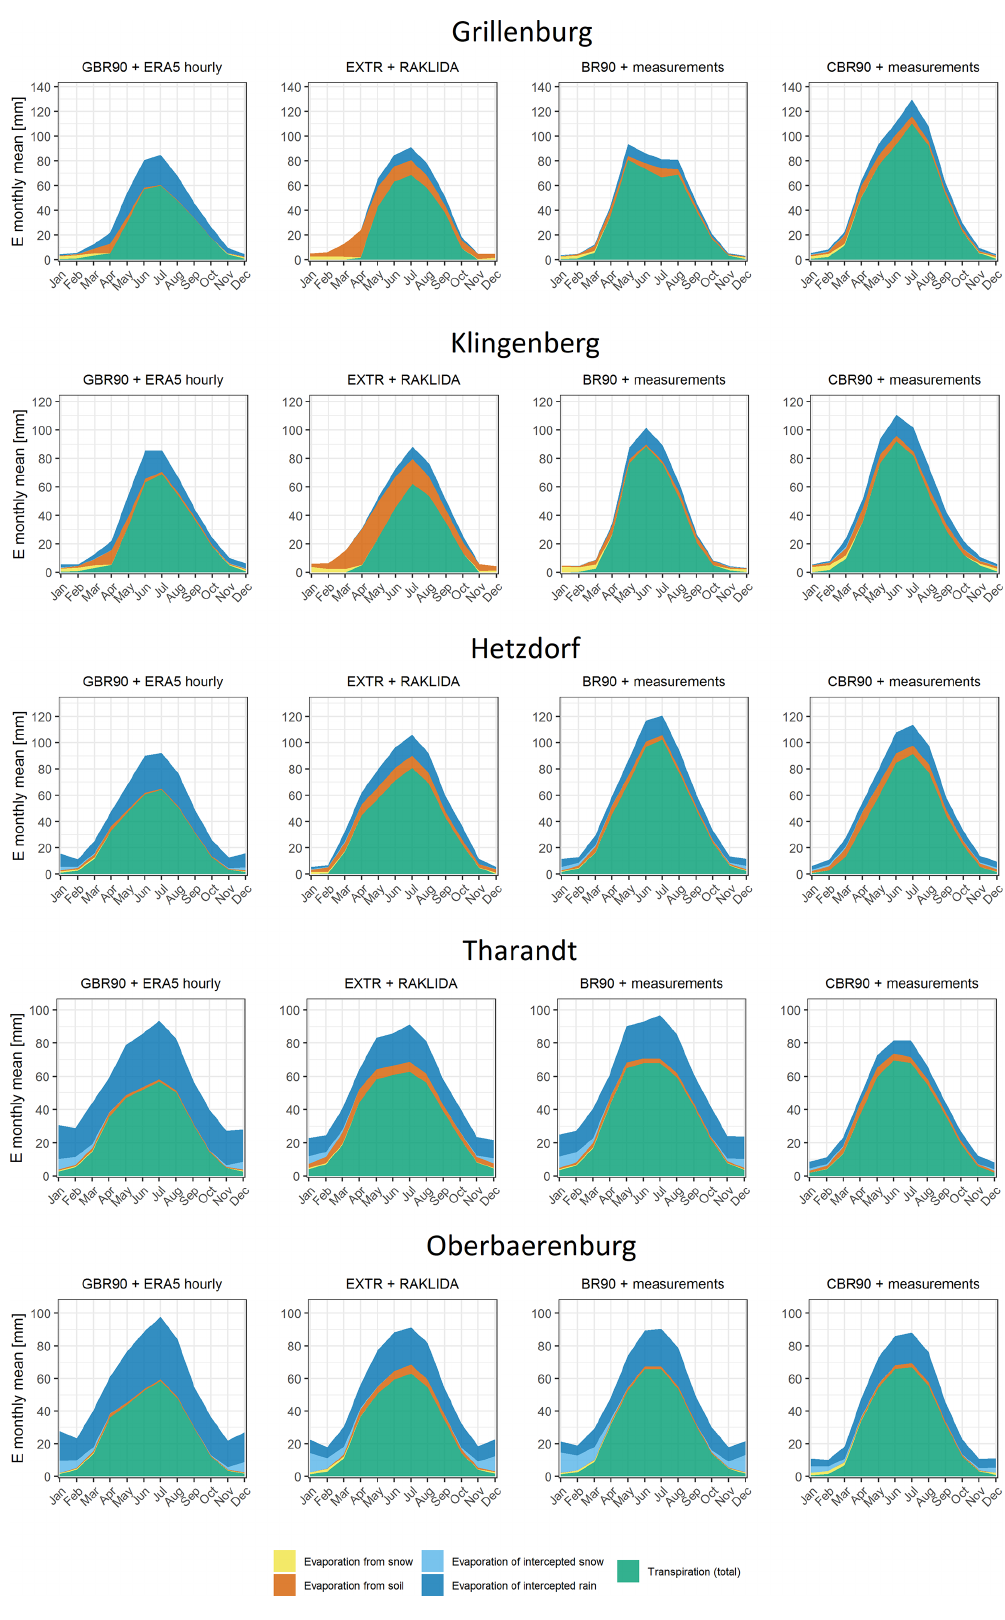
Figure 8. Modelled mean monthly evaporation